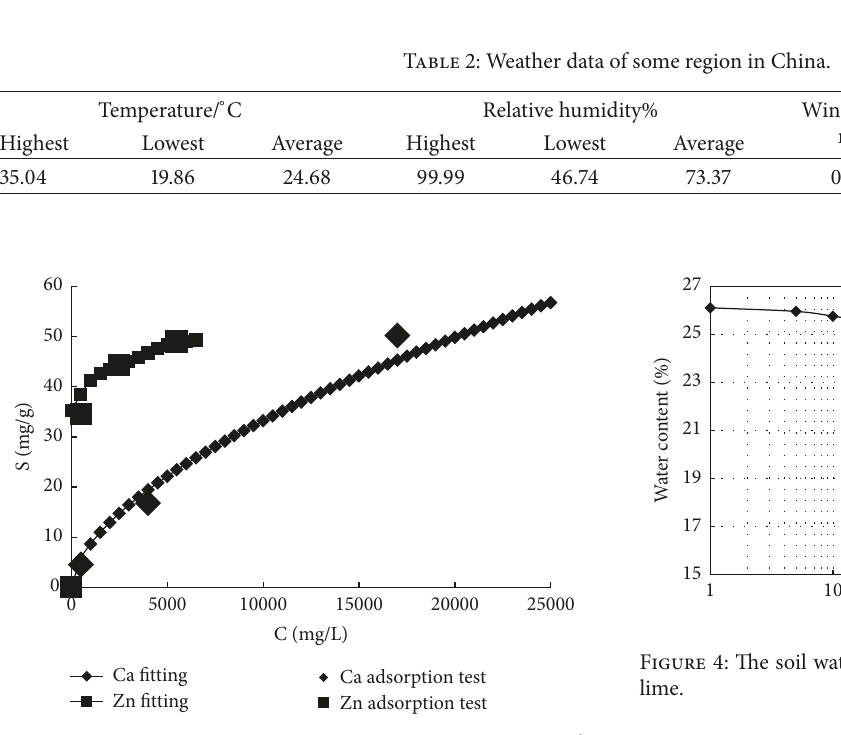
Figure 3: Fitting of the Freundlich adsorption isotherm of Ca 2+ ions.